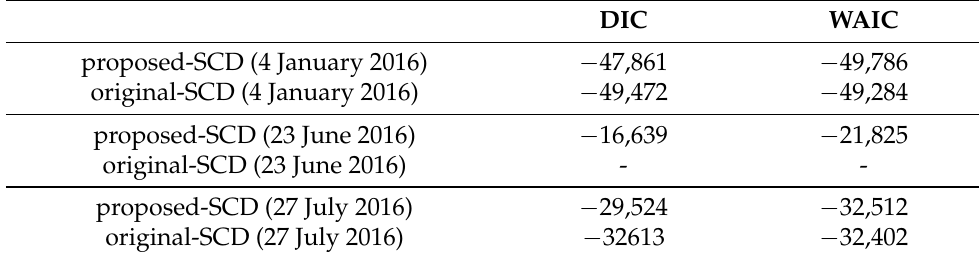
Table 31. Comparison of information criteria (JAL, Tokyo,